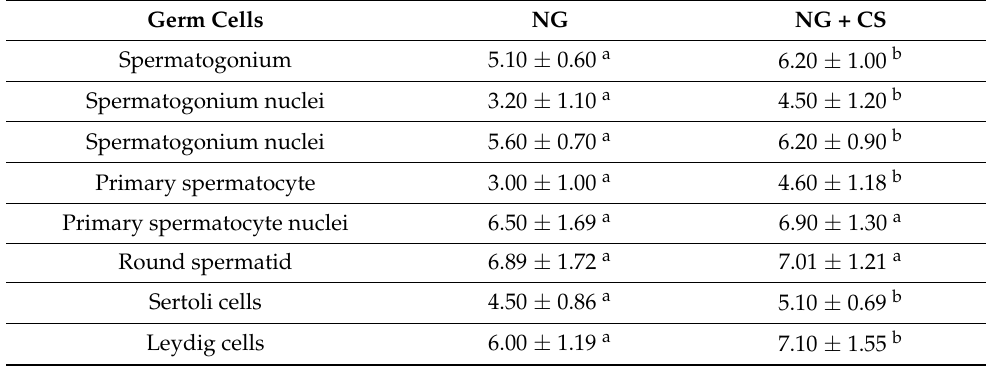
Figure 8. Immunofluorescence localization of ESR α protein in the testes of yaks under different feeding conditions: ( A – C ) natural grazing without concentrate supplementation; ( D – F ) natural grazing plus concentrate supplementation. Scale bar = 100 µ m ( A – F ). Table 3. Spermatogenic cells and their nuclei diameters ( µ m) in the testes of yaks (mean ±